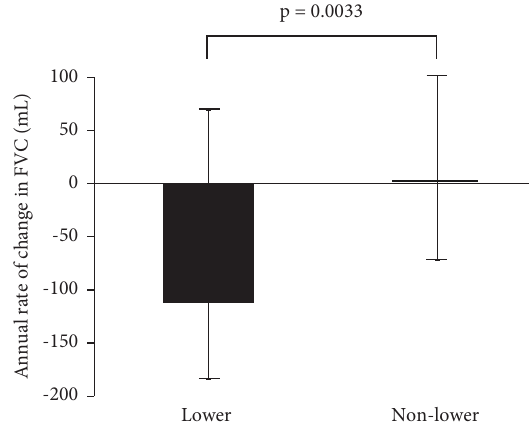
Figure 2: Te annual rate of decline over time in forced vital capacity (FVC) in lower dominance and nonlower